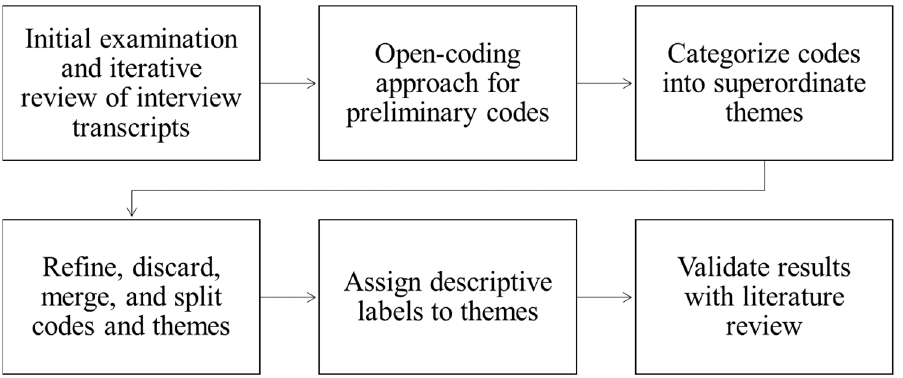
Figure 1. Thematic Analysis